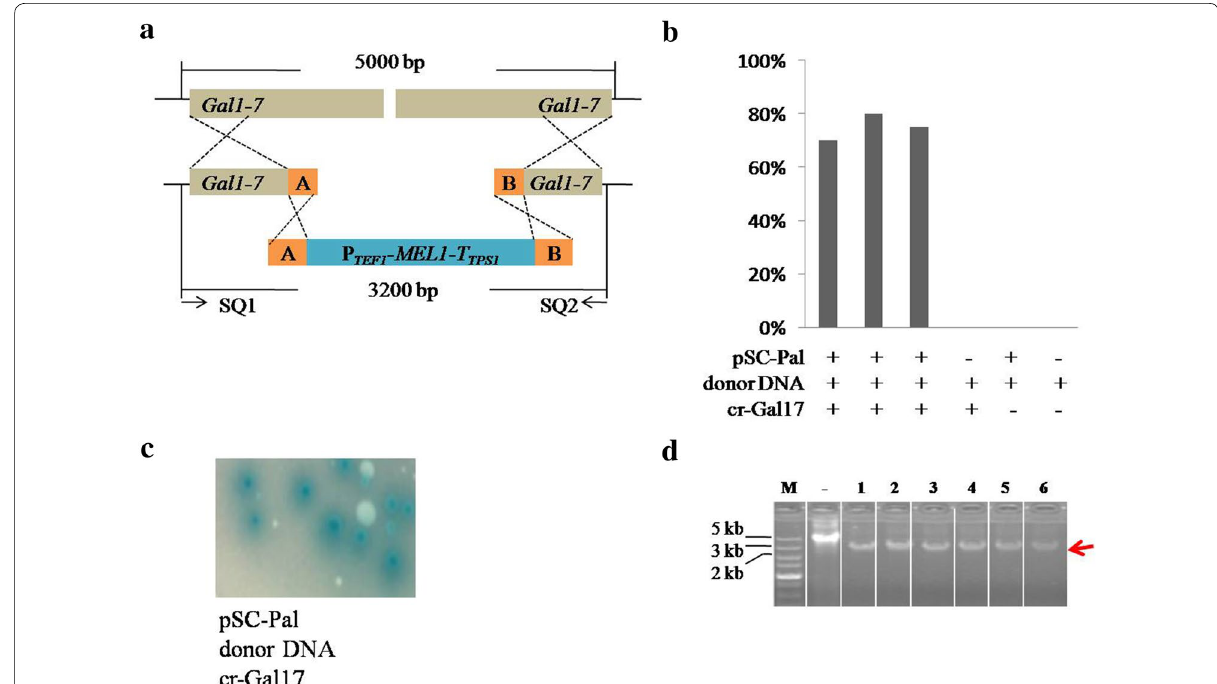
Fig. 3 scCRISPR/Cpf1 facilitated singleplex genomic integration of in vivo assembled DNA parts in S. cerevisiae . a scCRISPR/Cpf1 facilitated singleplex genomic integration of the MEL1 into the Gal1 ‑ 7 . b Efficiency of singleplex genomic integration assisted by scCRISPR/Cpf1. c Pictures of transformants obtained by co‑transforming donor DNA of MEL1 with pSC‑Pal and cr‑Gal17. d PCR result of 1 white transformant ( transformants, lines #1–6, using primer pair SQ1/SQ2. a , b in orange rectangle: 50 bp homologous connector sequences. P TEF1 , promoter of the TEF1 ; T TPS1 , terminator of the